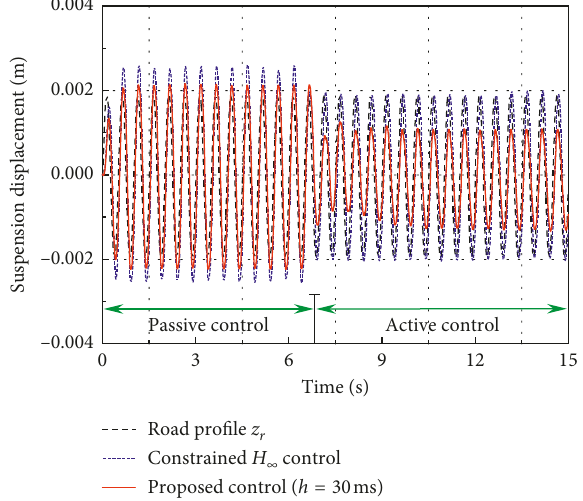
Figure 12: Hardware results of car-body acceleration under square wave signal.